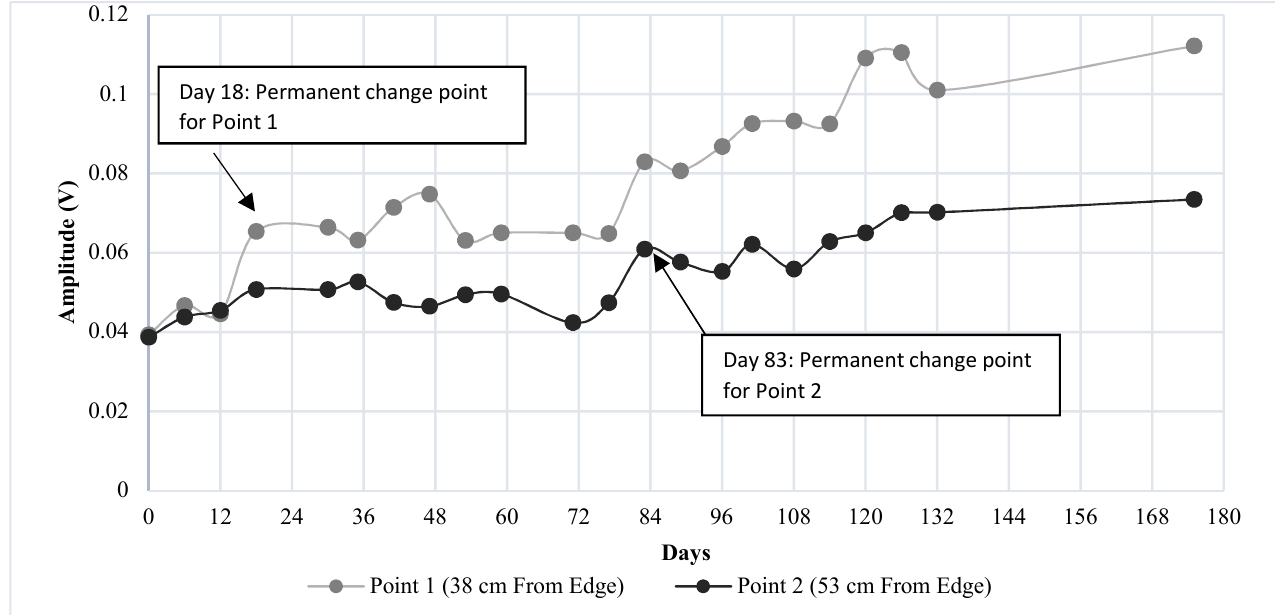
Figure 6. Comparison of select data through 175 days, Specimen A.